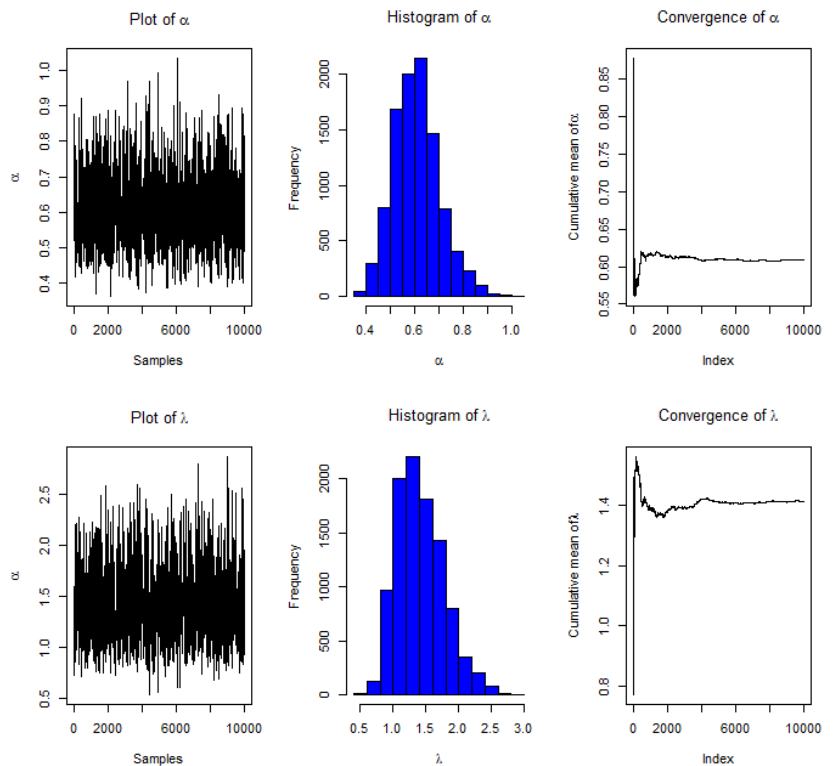
Figure 2. Convergence of MCMC estimates for α and λ using MH algorithm under PT1C3 and CT − I where m = 3 and n = 50.